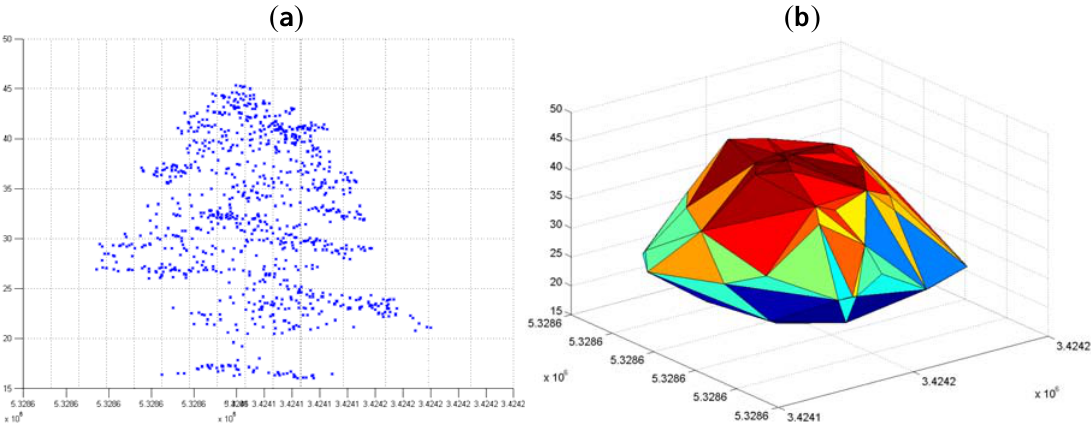
down the height value on the dataset above 16 m height and respective convex polytope. ( a ) Cell 6—an individual tree cluster above 16 m height. ( b ) 3-D Convex polytope reconstructed from an individual tree cluster as shown in ( a ). The x and y coordinate values (in meters) are displayed horizontally and the z value (in meters) is displayed